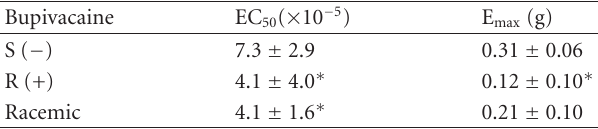
Table 1: EC 50 values and maximum contraction by